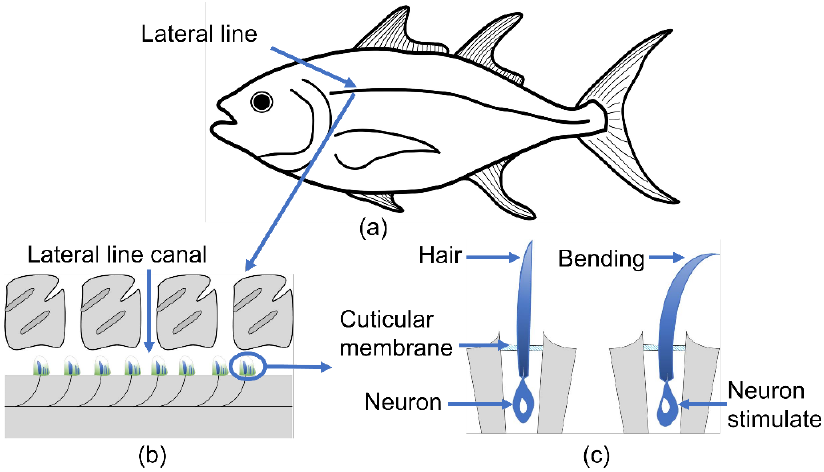
Figure 1. Schematic of bionic principle. ( a ) Fish lateral line; ( b ) basic unit of the lateral sensory organ; ( c ) haircell sensing principle.